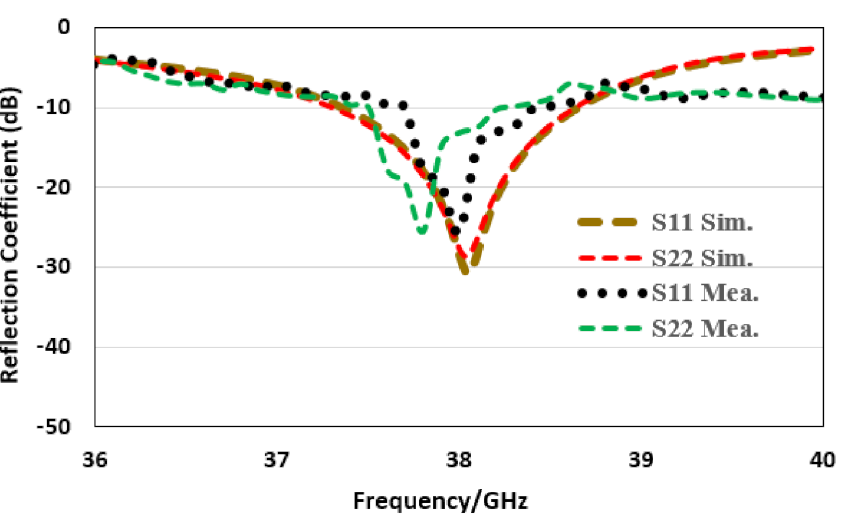
Figure 7. Corporate array MIMO configuration reflection coefficient.